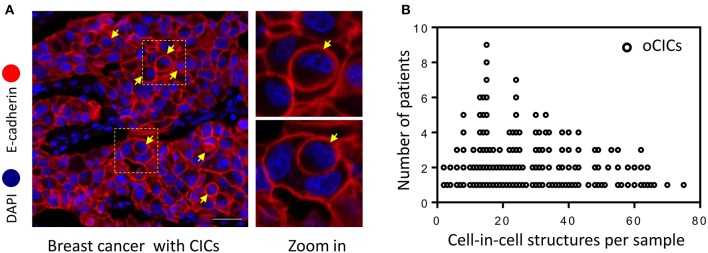
Cell-in-cell structures in breast cancer. (A) Representative image for CICs in human breast cancer tissue stained with antibodies for E-cadherin. Nuclei were counterstained with DAPI. Right panel shows zoomed images for boxed region in the left image. Yellow arrows indicate inner cells of cell-in-cell structures. Scale bar: 20 μm. (B) Distribution of overall CICs (oCICs) across breast cancer tissues from different patients.